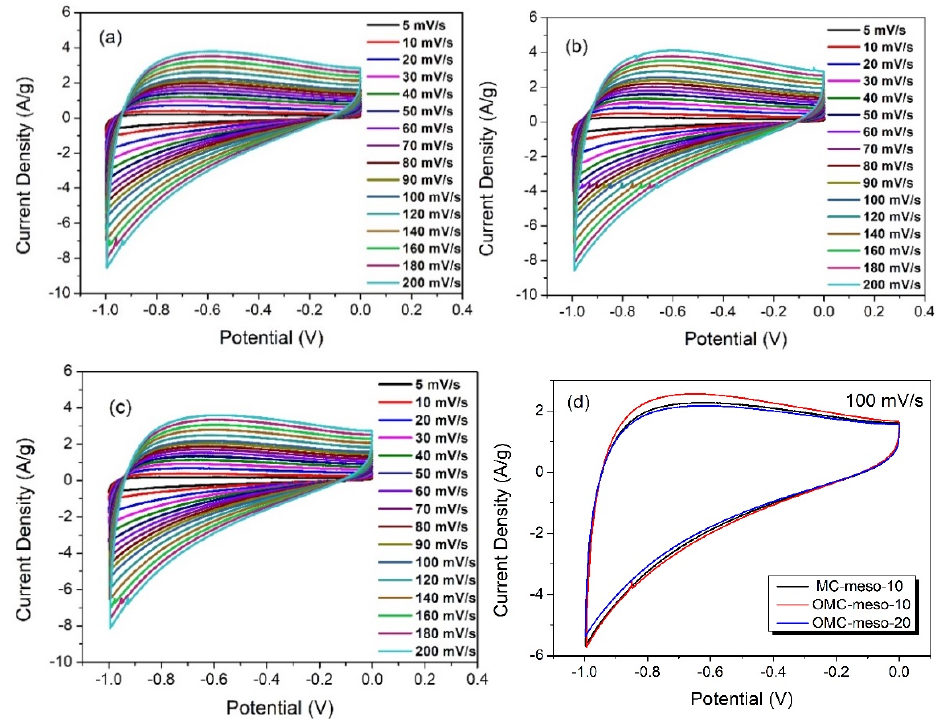
Figure 6. CV curves of MC-meso-10 ( a ), OMC-meso-10 ( b ), OMC-meso-20 ( c ) at scan rates from 5 to 200 mV/s, and comparative CV curves ( d ) of MC and OMCs at 100 mV/s.